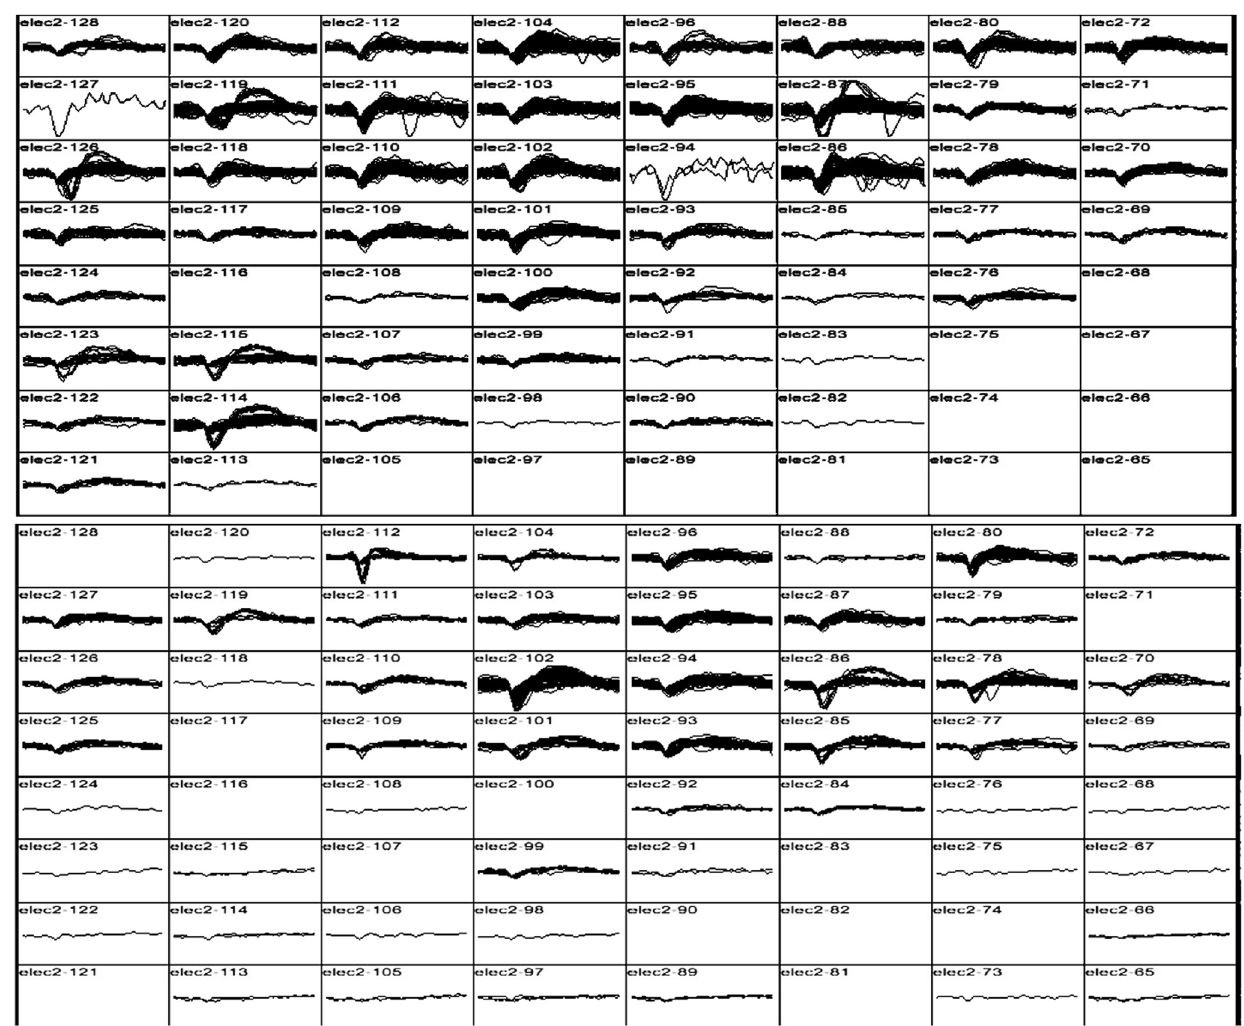
Fig. 4 Action potential waveforms. Snapshot of action potential waveforms recorded from two of the arrays.